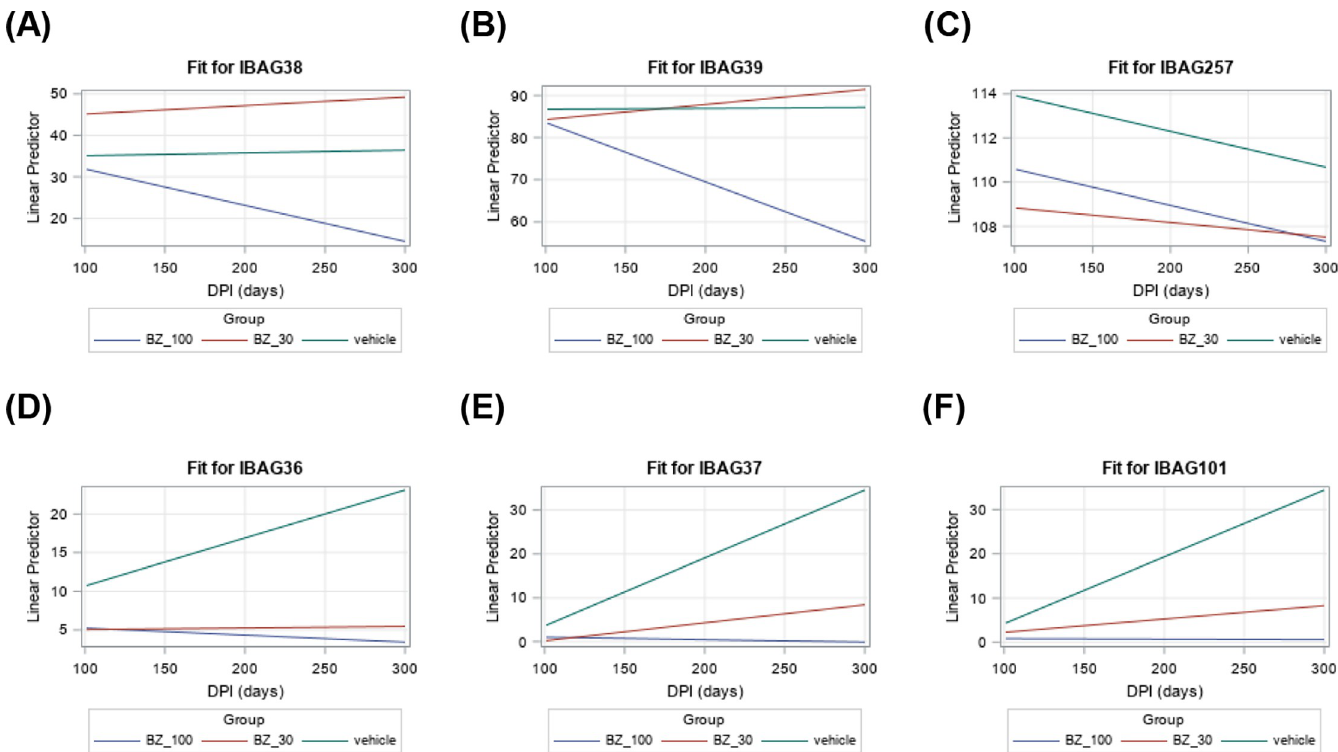
Fig 3. Average change of IBAG reactivity over time, based on the linear prediction model for mice treated with vehicle, and benznidazole at 30 and 100 mg kg -1 . The fits correspond to the intercept and slopes in Table 1. The reactivity of (A) IBAG38 and (B) IBAG39 remains stable in mice treated with vehicle and benznidazole at 30 mg kg -1 and sharply decreases in 100 mg kg -1 benznidazole treated mice. (C) IBAG257 declines in reactivity in the three groups. The reactivities of (D) IBAG36, (E) IBAG37 and (F) IBAG101 increase only in vehicle-treated animals. The vertical axis is representative for the real intensity of the